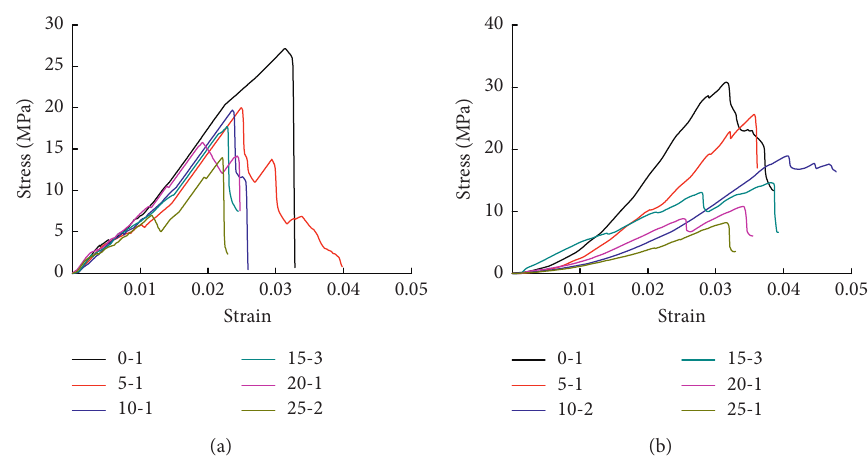
Figure 7: Stress-strain curves of the feldspar sandstones after a dry-wet cycle. (a) Group A. (b) Group